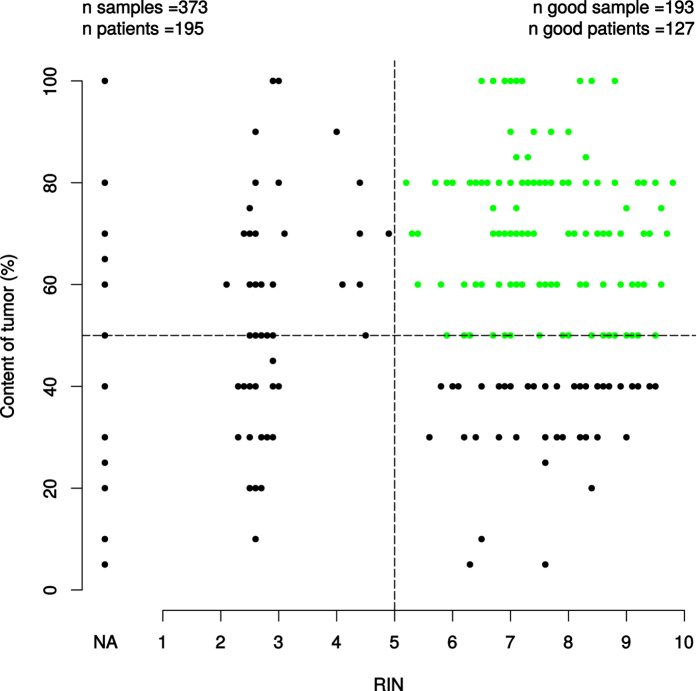
Of 195 analyzed patients (matched to available clinical data sets) 127 patients (65.13%) (good patients) were included for further molecular analyses (tumor content > 50%, RIN > 5).RNAlater biopsy samples not fullfilling the criterions (tumor content < 50%, RIN < 5) were excluded (patients n = 68, 34.87%). The RIN = NA depicts missing RIN-values in the set, which led to exclusion in subsequent RIN vs X analysis.